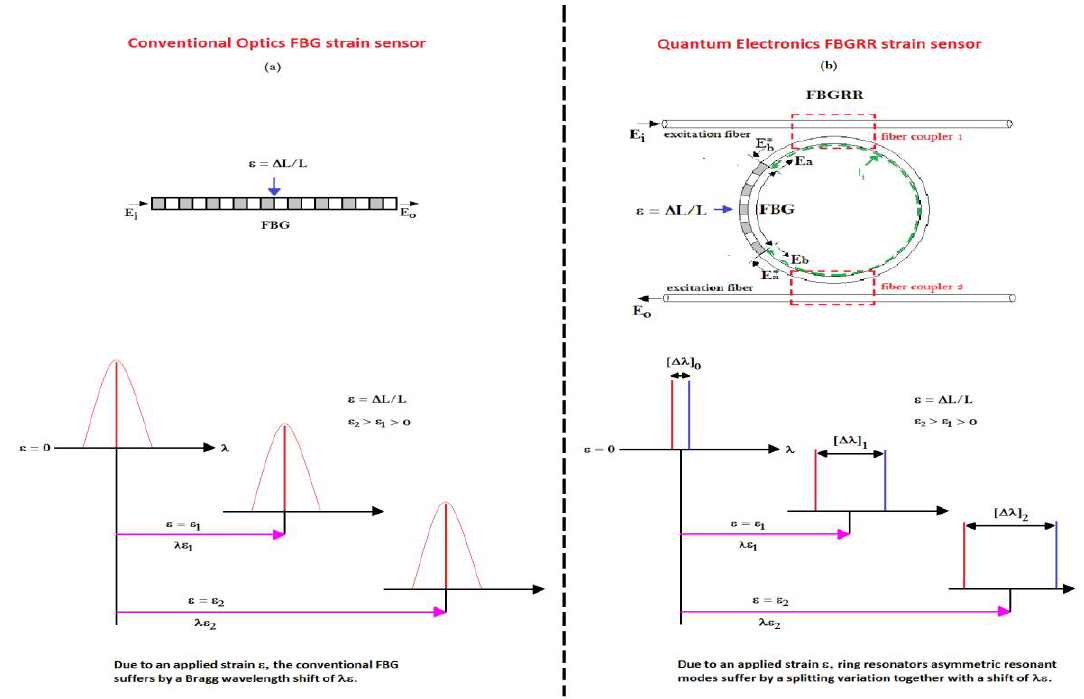
Figure 10. ( a ) FBG conventional static strain sensor; ( b ) fibre Bragg grating ring resonators (FBGRR) strain sensor system, consisting in a FBG inserted into a ring resonator made by an optic fibre closed on itself into a feedback loop, through two fibre couplers.